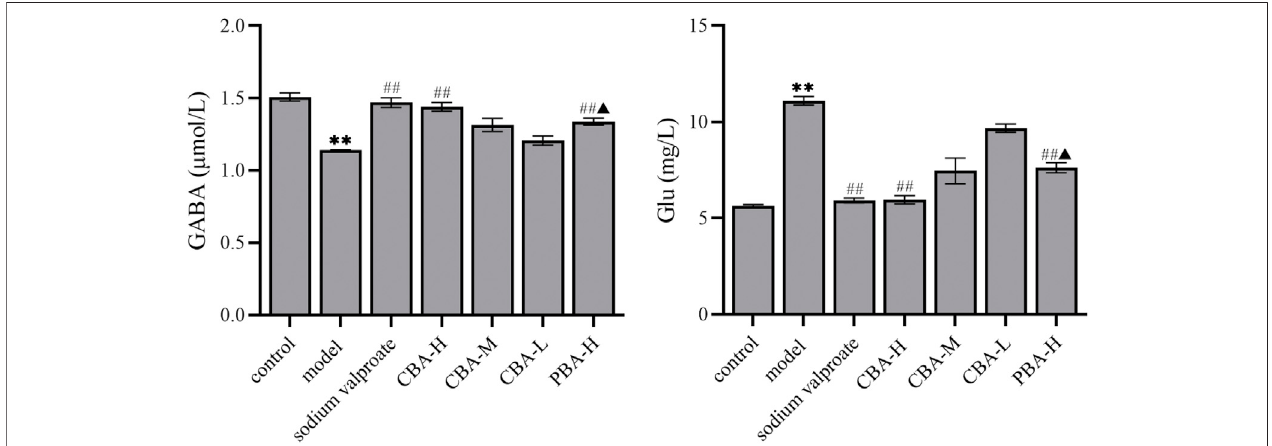
FIGURE3| CBAregulatedtheneurotransmitterdisorderinFSrathippocampus.Dataofneurotransmittercontentswerecalculatedasthemean±SEM.** p < 0.01 compared to that of the control group; ## p < 0.01 compared to that of the model group; ▲ p < 0.05 compared to that of the CBA-H